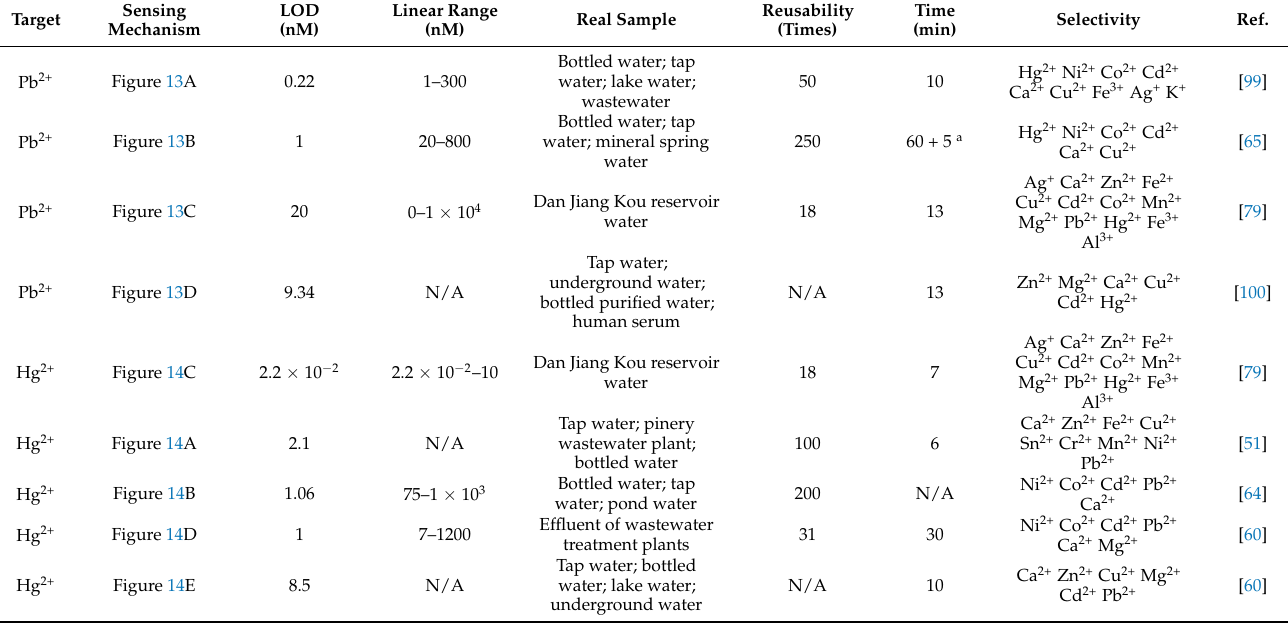
Table 2. Detection of heavy metal